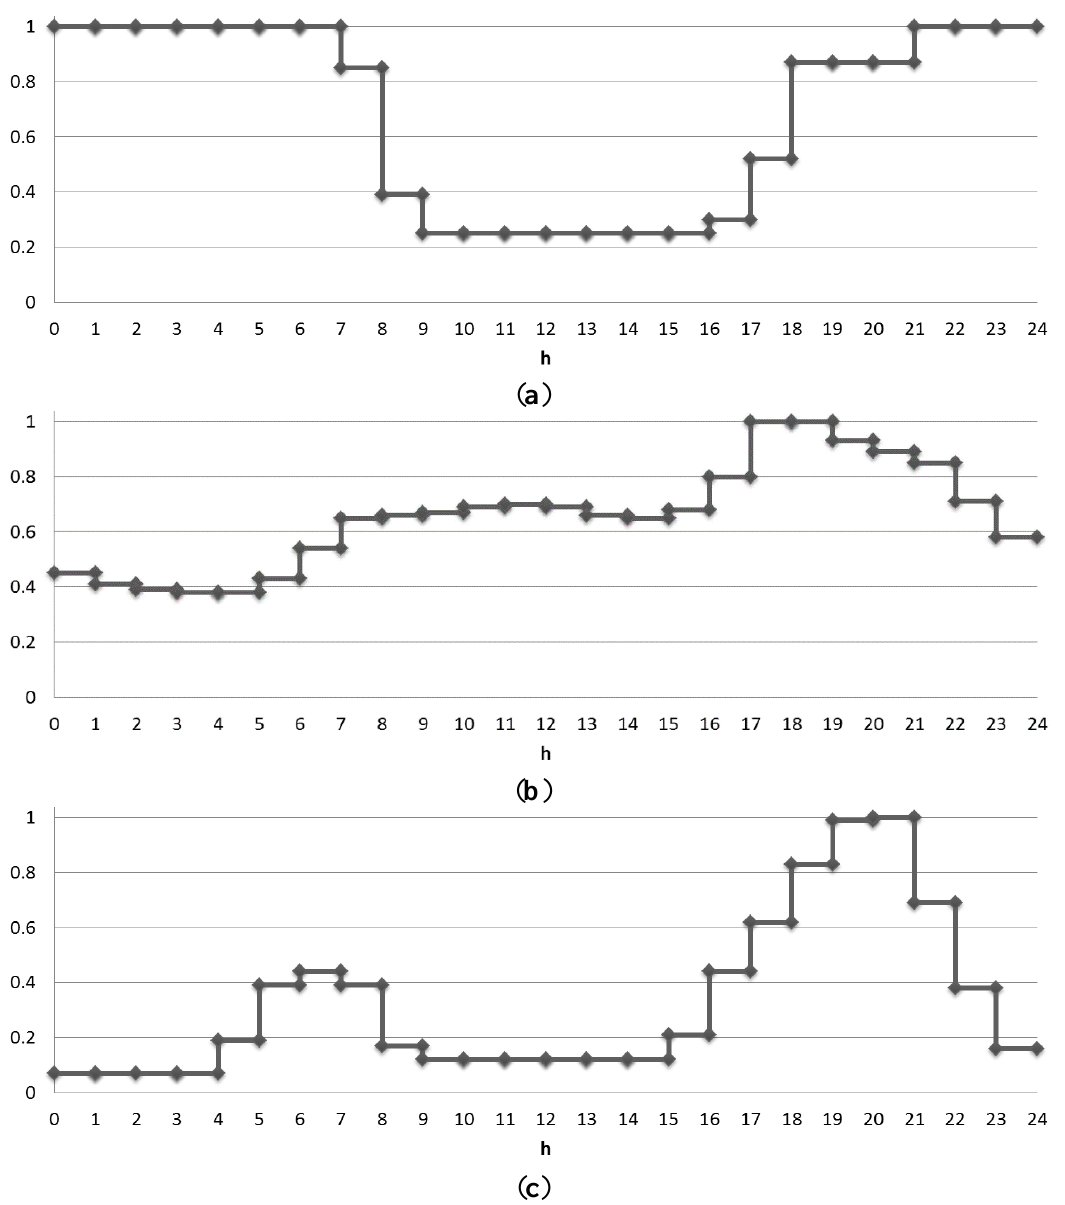
Figure 8 summarizes primary energy consumptions for every analyzed design scenario; annual primary energy consumption includes the energy for space heating and cooling, ventilation, lighting, equipment and domestic hot water. The amount of primary energy produced by the renewable energy sources (solar and photovoltaic panels installed on the roof) has been subtracted form total consumption in order to consider the net building primary energy delivered. Indeed, according to the cost-optimal methodology that expresses all energy uses with a single primary energy indicator, the renewable sources-based technologies enter into direct competition with the demand-side solution; this is in line with the purpose of the cost-optimal calculation to identify the solution that represents the least global cost without discriminating against or favoring a certain